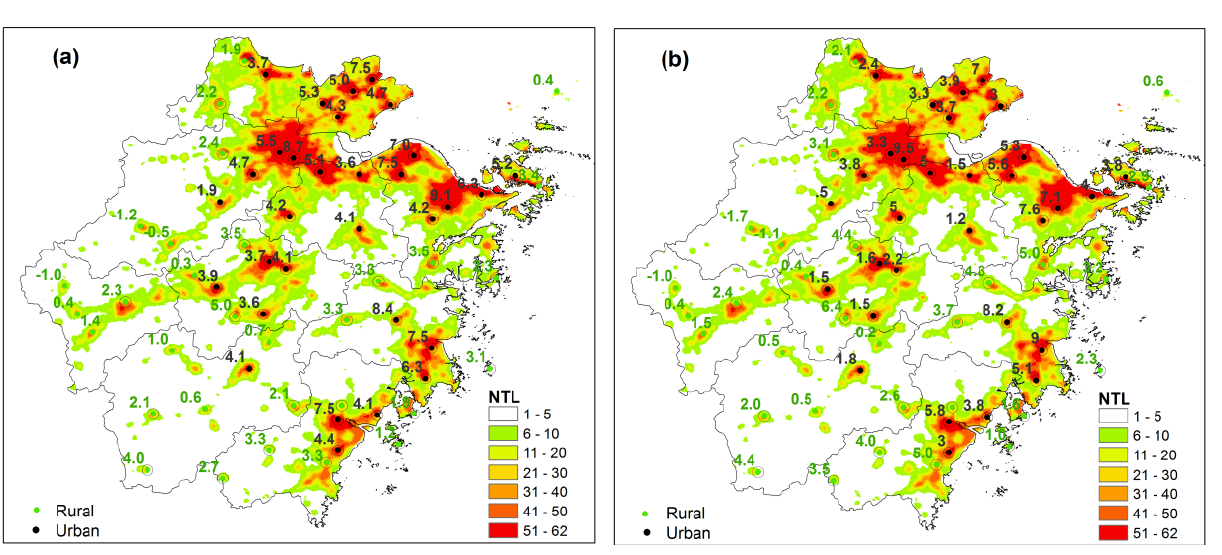
Figure 6. DMSP/OLS nighttime light in 2010 and spatial pattern of ( a ) hot days (day/10 a) and ( b ) hot degree days (°C·day /10 a) trends based on the daily 95th percentile during 1971–2011 in ZJP. Circles indicate significant trends at the 5% significance